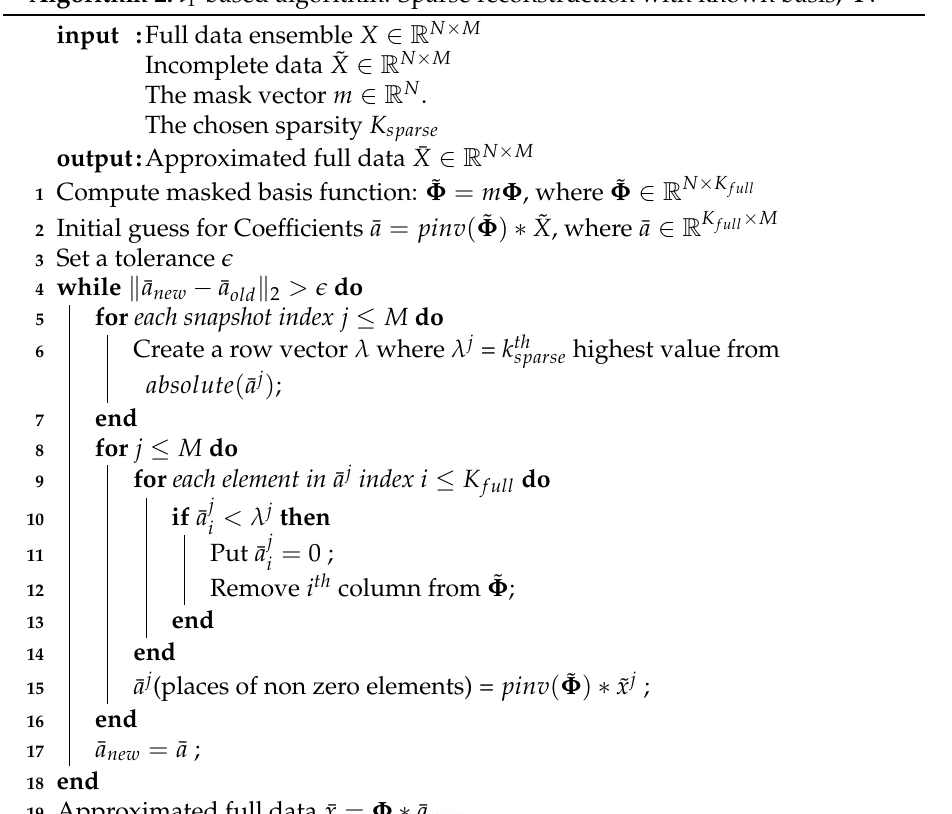
Algorithm 2: l 1 -based algorithm: Sparse reconstruction with known basis, Φ